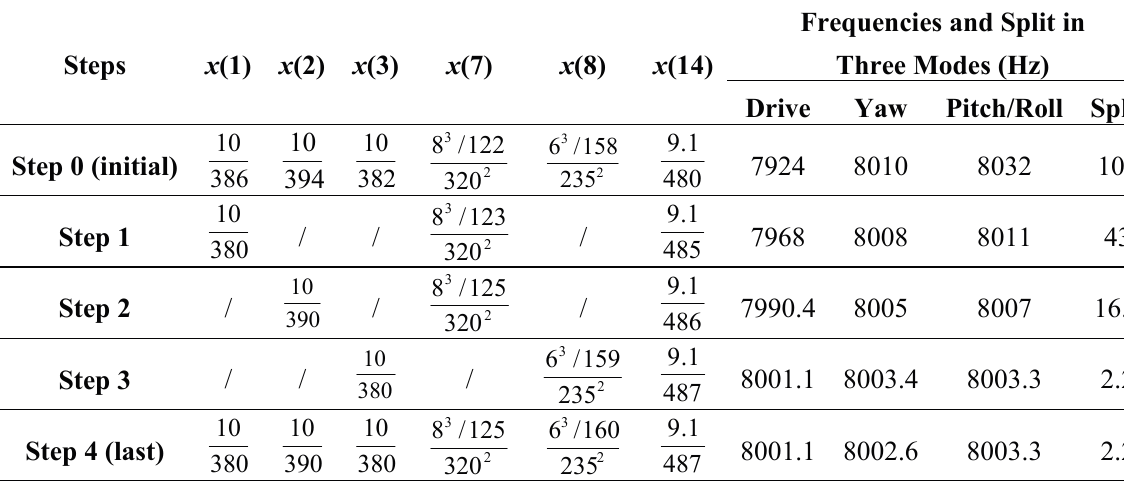
Table 7. The changed springs dimensions for further mode matching.